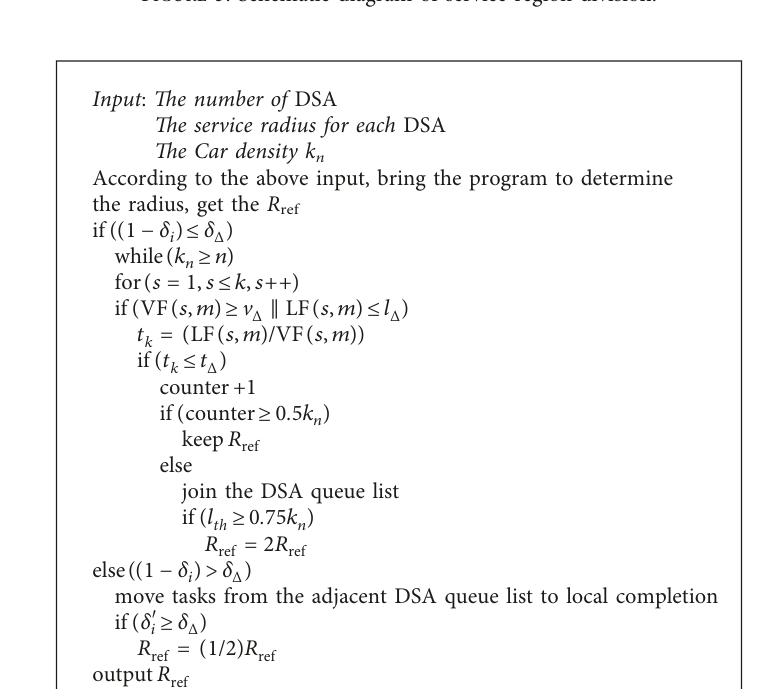
Figure 3: Schematic diagram of service region